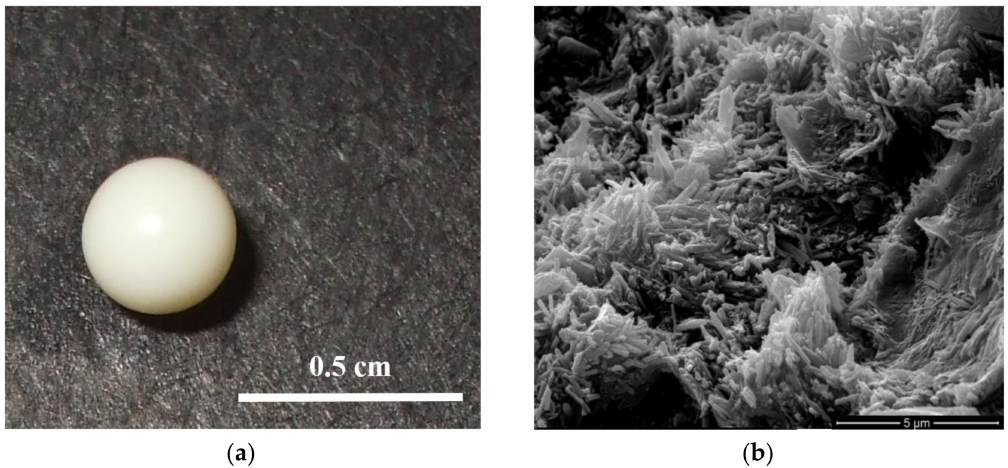
Figure 1. ( a ) Optical image of wet alginate/chitosan/halloysite nanotubes (HNTs) gel beads and ( b ) SEM image of the inner part of the dried gel beads.